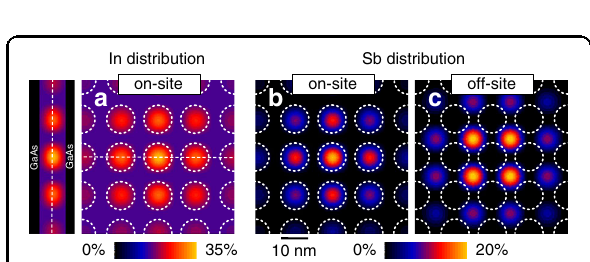
Fig. 6 For the 8-band k·p calculations, antimony and indium distributions were assumed as follows: The dashed white circles indicate the placement of the indium rich regions, a A sigmoidal indium distribution is adopted, with a peak local indium content of 35%. b Antimony distributions for scenarios (A) and (C), where the peal local antimony concentration is 20%. (reproduced from ref. 58